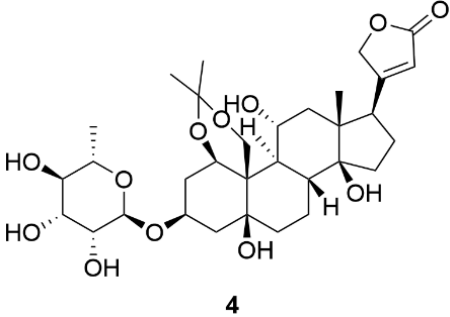
Figure 8. Chemical structure of compound 4 .